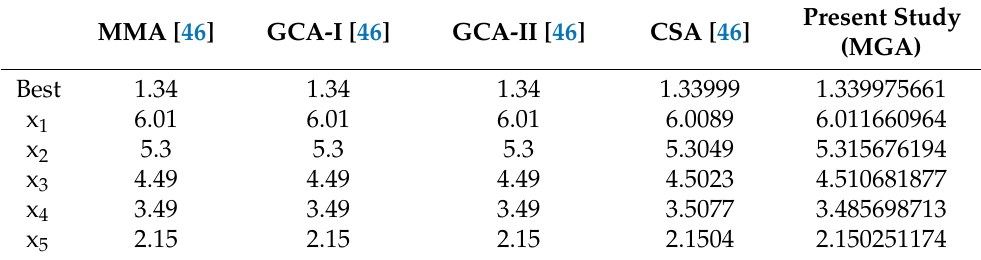
Table 27. Comparison of the best solutions for the cantilever beam design problem. MMA [46]